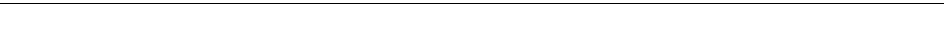
Figure 9. Shoreline on the north-western tip of Hart Island, 2021 (Source: